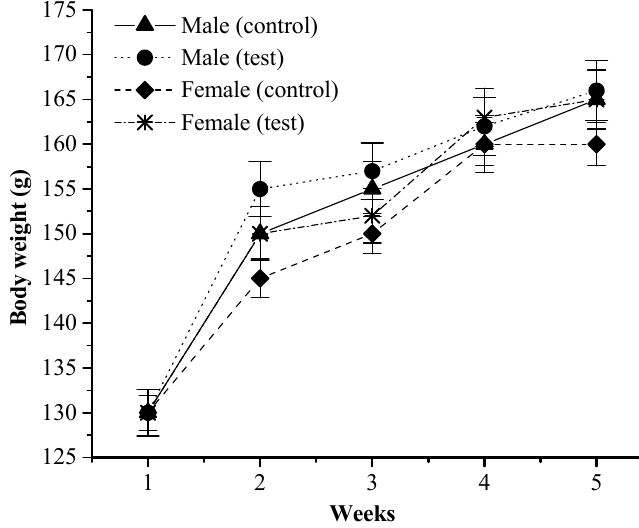
Figure 2. Mean food consumption in rats administered with tomato powder suspension (TPS) for 4 weeks. Each point represents mean of six determinations. Error ranges denote one standard deviation from the mean ( n =